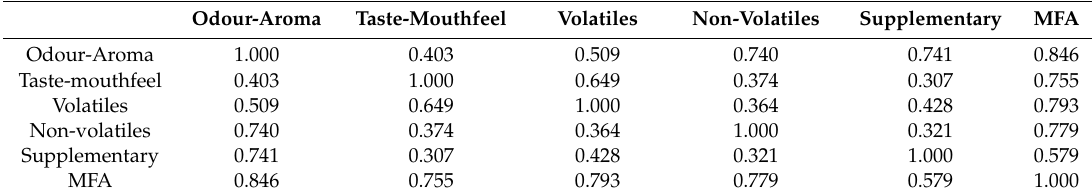
Table 5. RV coefficients between odour-aroma, taste-mouthfeel, volatiles, non-volatiles and supplementary data matrices of the